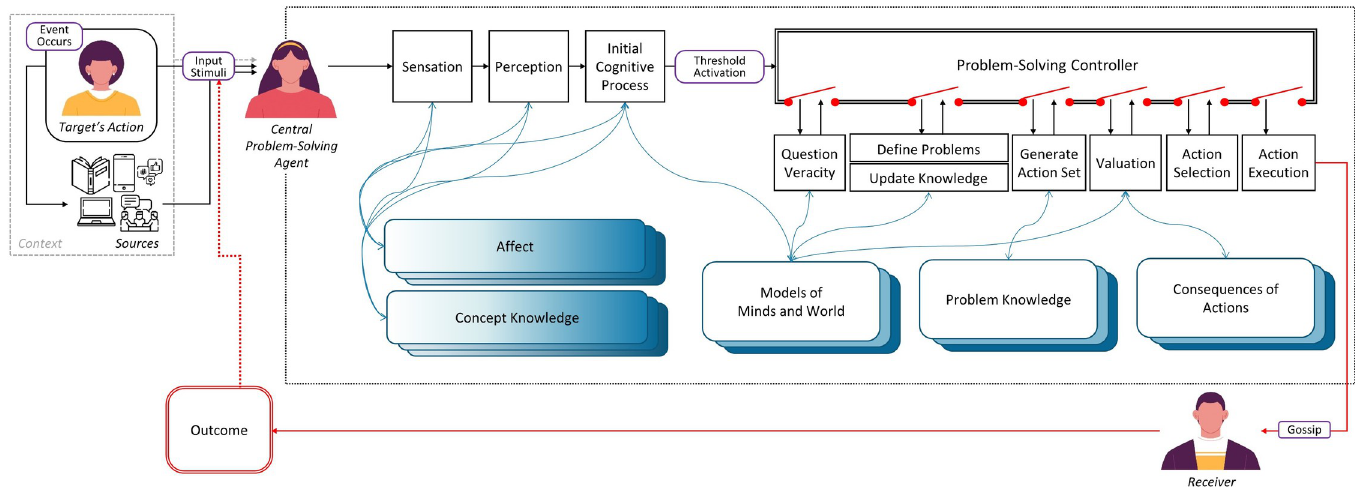
Fig 1. Our framework of social information processing. The central agent goes through a series of internal processes (black rectangles) after learning about some event involving a target individual, which includes accessing and updating relevant knowledge (blue rounded rectangles), and determining whether to take action about it. See text and Lee, Kralik, Jeong [72–75] for details. (Three face images from: Freepik.com).